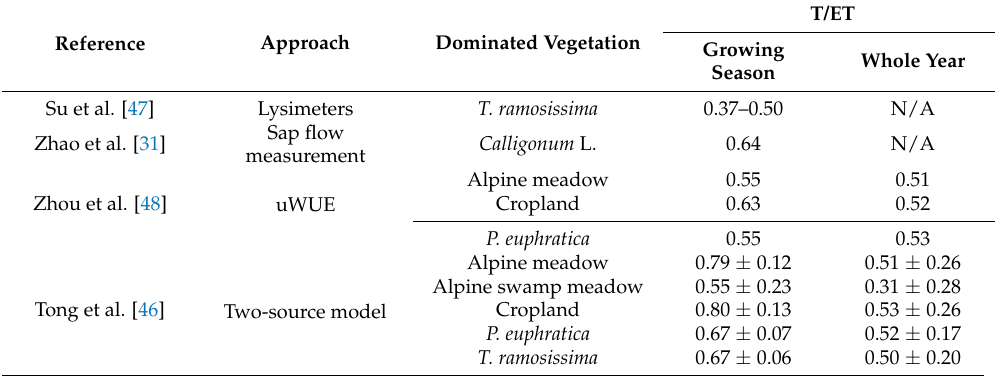
Table A2. Summary of transpiration fraction (T/ET) of typical ecosystems estimated by different method at daily time interval in the